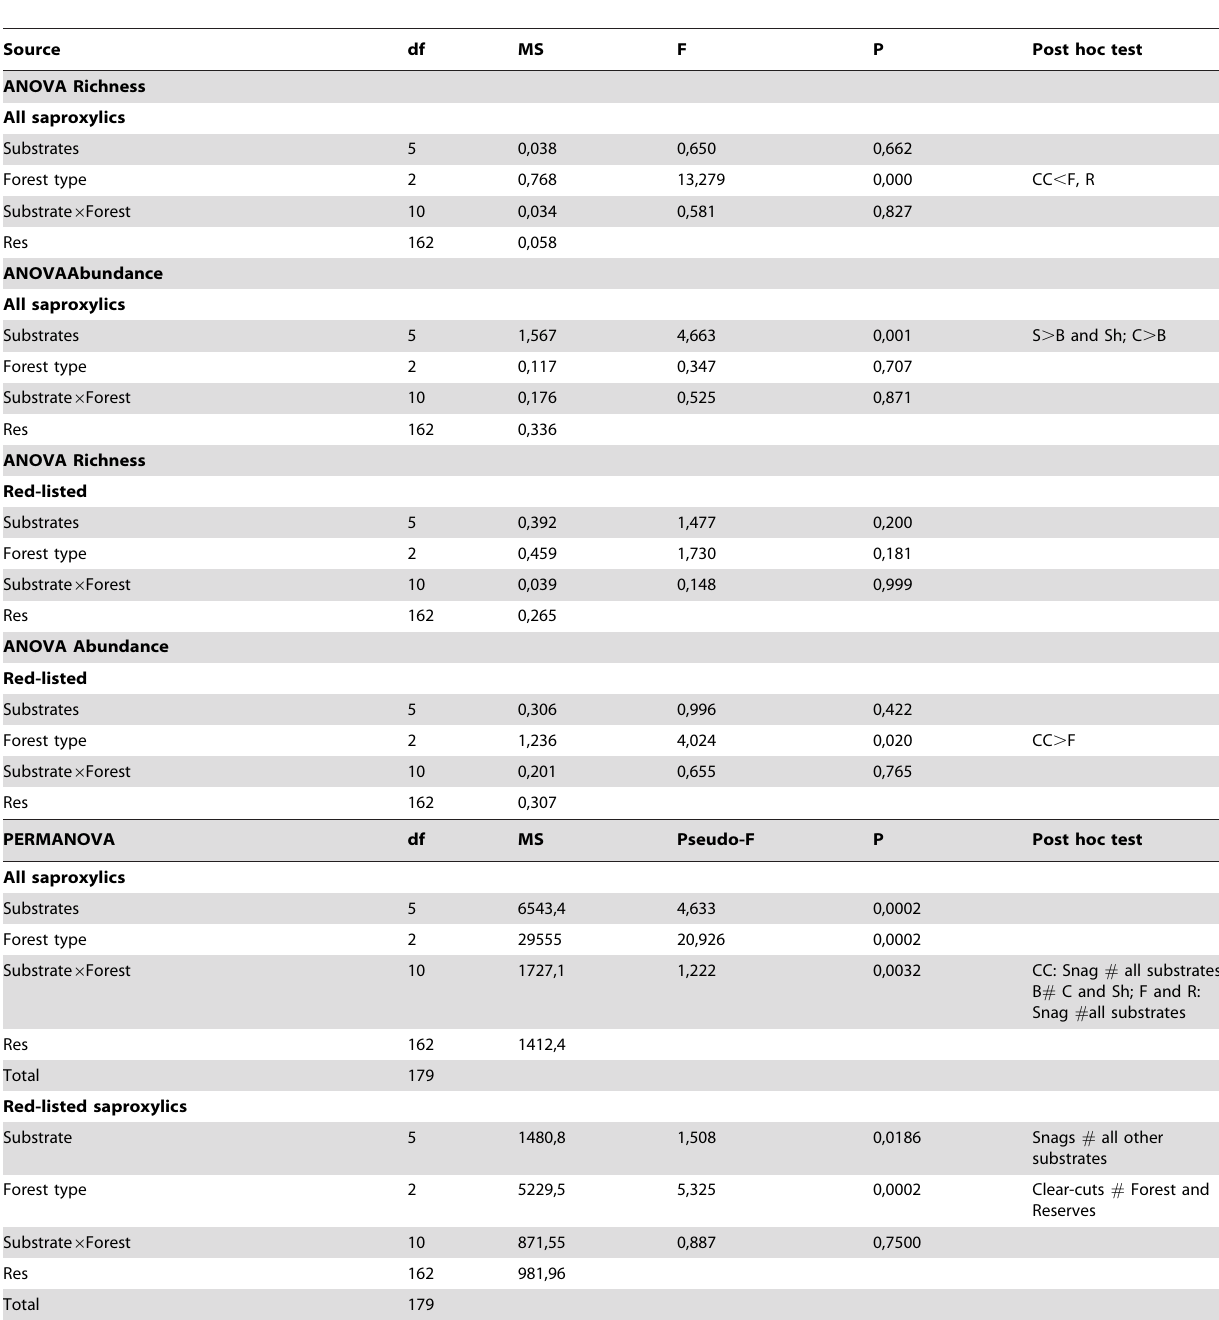
Table 1. ANOVA and PERMANOVA analyses testing the effect of substrate and forest type on species richness, abundance and assemblage composition of all saproxylic species and red-listed species